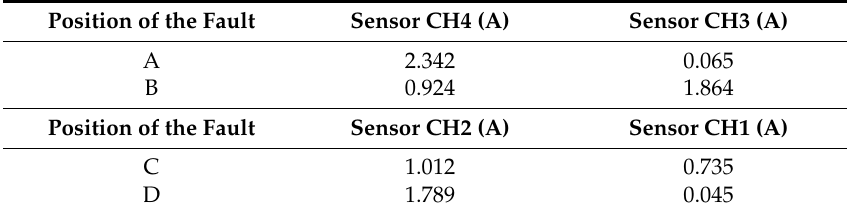
Table 8. Ground fault currents in shield with load connected with test voltage of 105 Vdc.